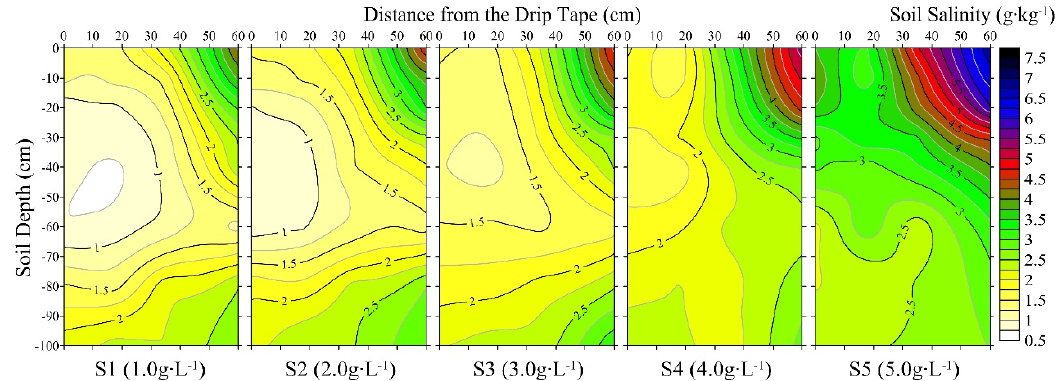
Figure 8. Soil salt distribution for different irrigation water salinity.